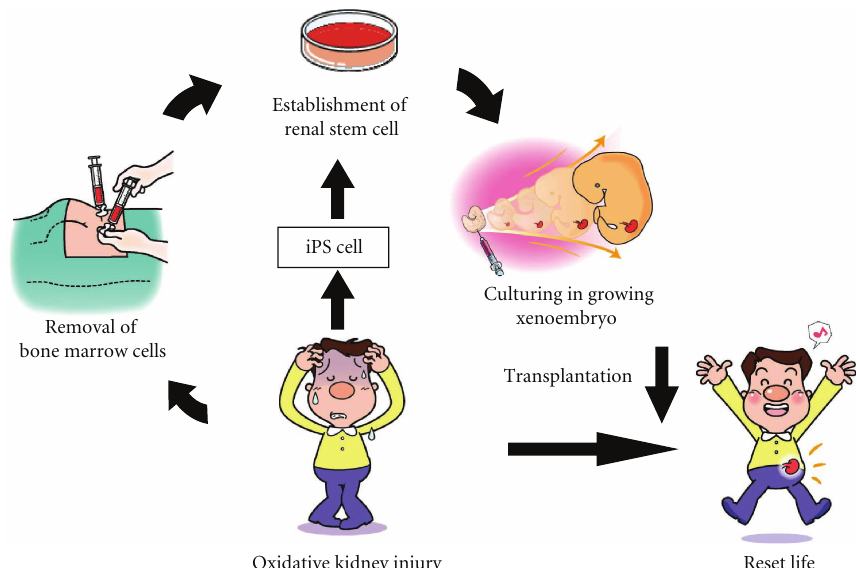
Figure 4: Putative scenario for the application of stem cell biology to kidney regeneration. Renal stem cells derived from bone marrow cells or skin fibroblasts of a dialysis patient are cultured in a growing xenoembryo for a given time to develop into kidney primordia, followed by their autologous implantation into the omentum of the same patient. Kidney primordia eventually become a self-organ that performs mature renal functions. The patient may experience relief from dialysis and completely overcome the renal